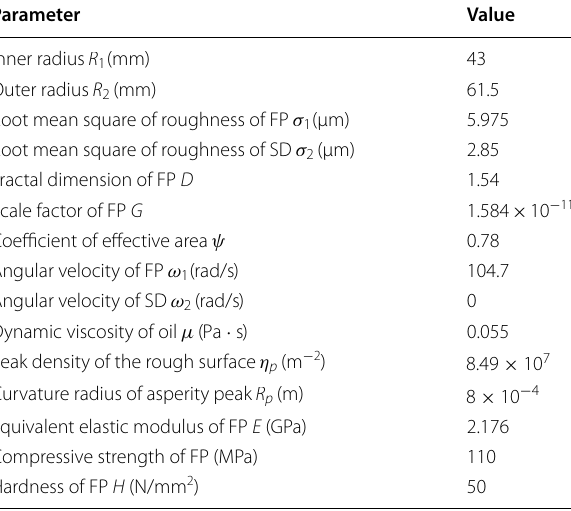
Table 2 Parameters of structure, material, and